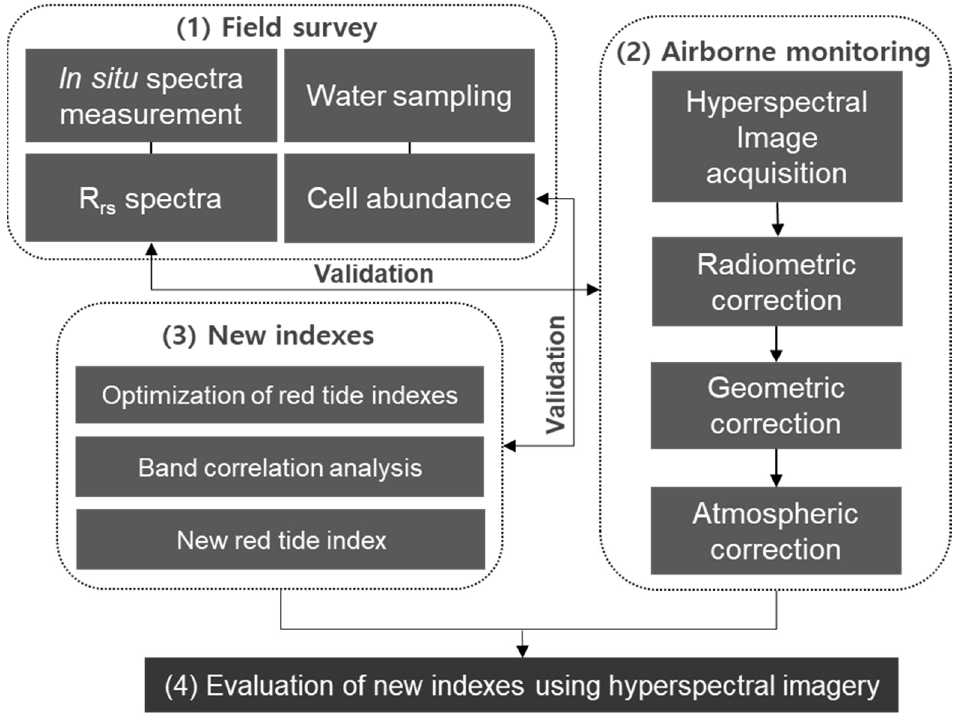
Figure 2. Schematic diagram of the procedure for quantifying cell abundance of red tide blooms. ( 1 ) Field survey for in situ spectrum measurement and water sampling; ( 2 ) Pre-correction of HSI obtained through airborne monitoring; ( 3 ) Identification of new indexes for quantifying M. polykrikoides cell abundance; ( 4 ) Evaluation of the performance of new indexes when applied to HSI.